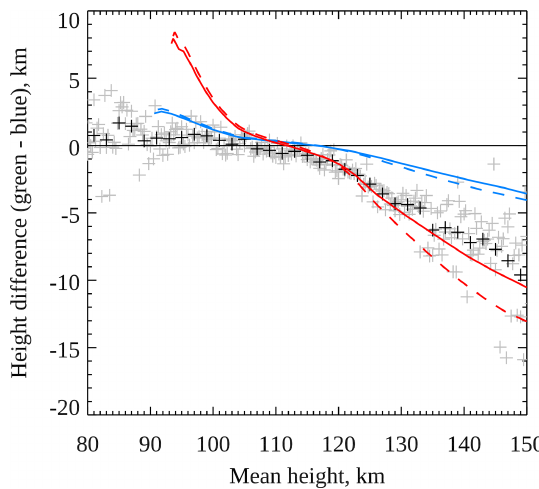
Figure 9. Observed and modelled difference in height between the green 557.7nm and blue 427.8nm emissions as a function of their mean height. Observations are shown as plus symbols. Grey symbols show the average height difference over all observations with the same mean height (to the nearest 0.25km). Black symbols show the same but where observations have been binned into 2km wide bins of mean height (reproduced from Fig. 4). The blue and red curves show the model results for Gaussian- and Maxwellian- shaped electron precipitation spectra, respectively, where the model is run for 12s (steady state, solid curves) or for 3s (dashed curves).